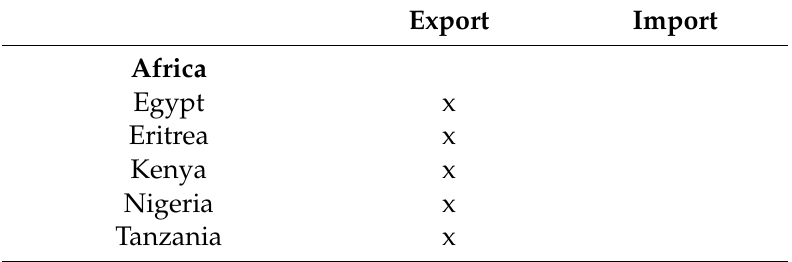
Table 1. Countries and regions of export and import of ornamental fishes that included marine fishes between 1962 and